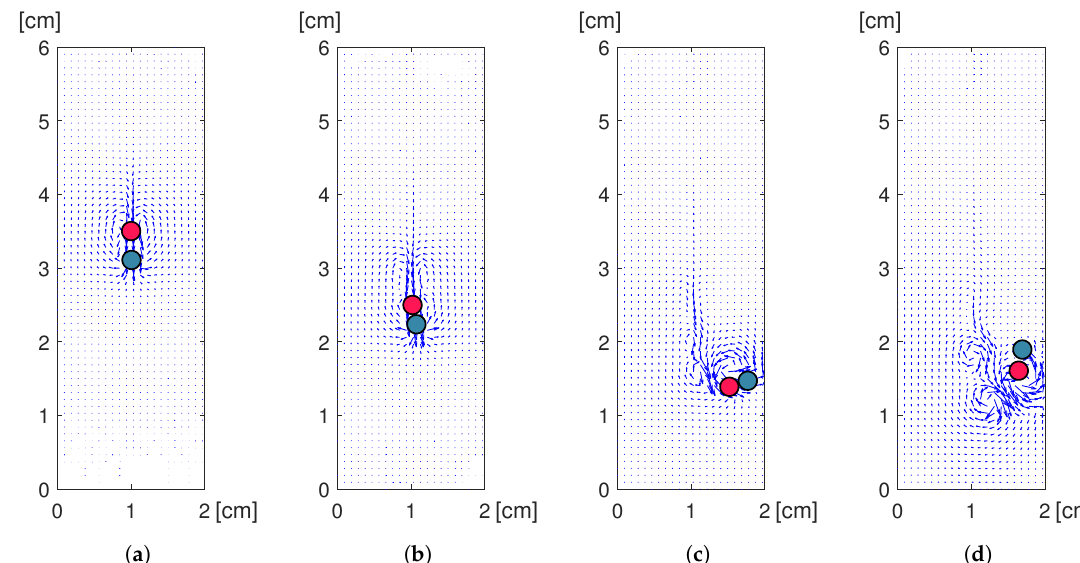
Figure 5. The positions of two tandem circular disks and the associated flow velocity field at time